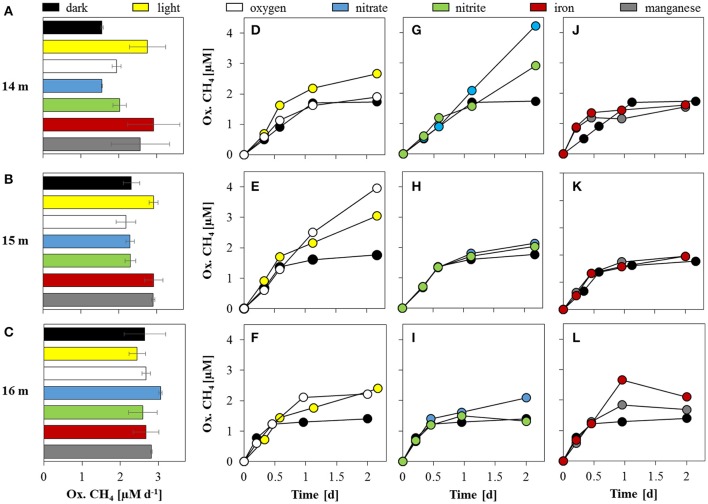
Methane oxidation potential at and below the oxycline. Methane oxidation rates (A–C) and corresponding oxidation time series are displayed for 14 m (top panel), 15 m (center panel), and 16 m (bottom panel). (D–F) Time series of oxidized methane under dark and light conditions; (G–I) with additions of nitrate and nitrite; and (J–L) iron and manganese. The dark control series is displayed for reference in all panels. Methane oxidation rates in (A–C) are calculated based on the initial ~12 h linear segments of the time series in (D–L).